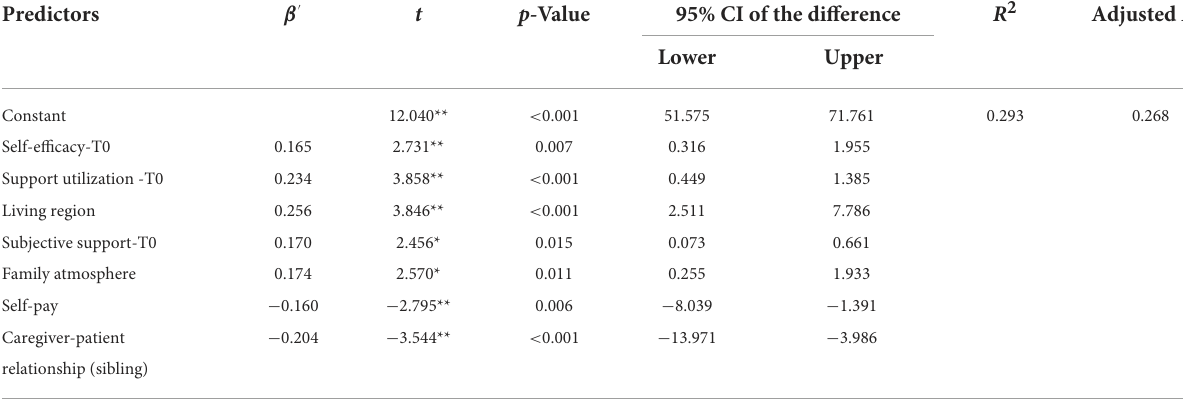
TABLE 5 Multiple linear regression for baseline predictors of family resilience at 6 months ( N =